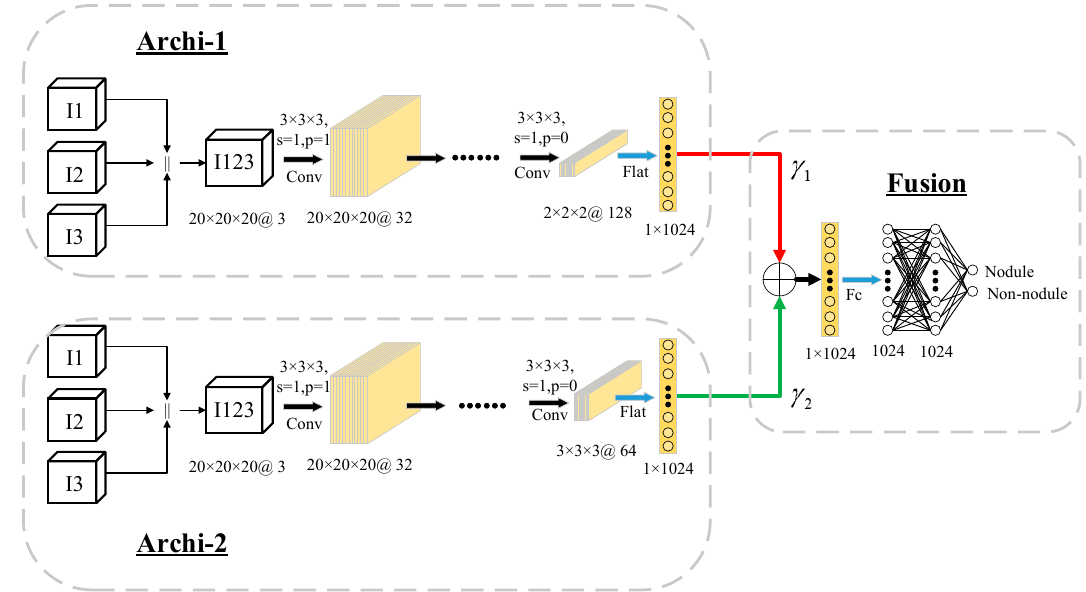
Figure 5. The network structure of multi-scale heterogeneous three-dimensional (3D) convolutional neural network with radical integration (MSH-CNN-RI): radical integration of nodule blocks on the same layer. The two branches of the network have the same structure as the MSH-CNN. The numbers above the thick arrows represent kernel size, e.g., 3 × 3 × 3 (s: stride, p: padding, Conv: 3D convolution). The figure after @ denotes the number of channels. The parameters γ 1 and γ 2 are weights automatically learned from the training dataset.